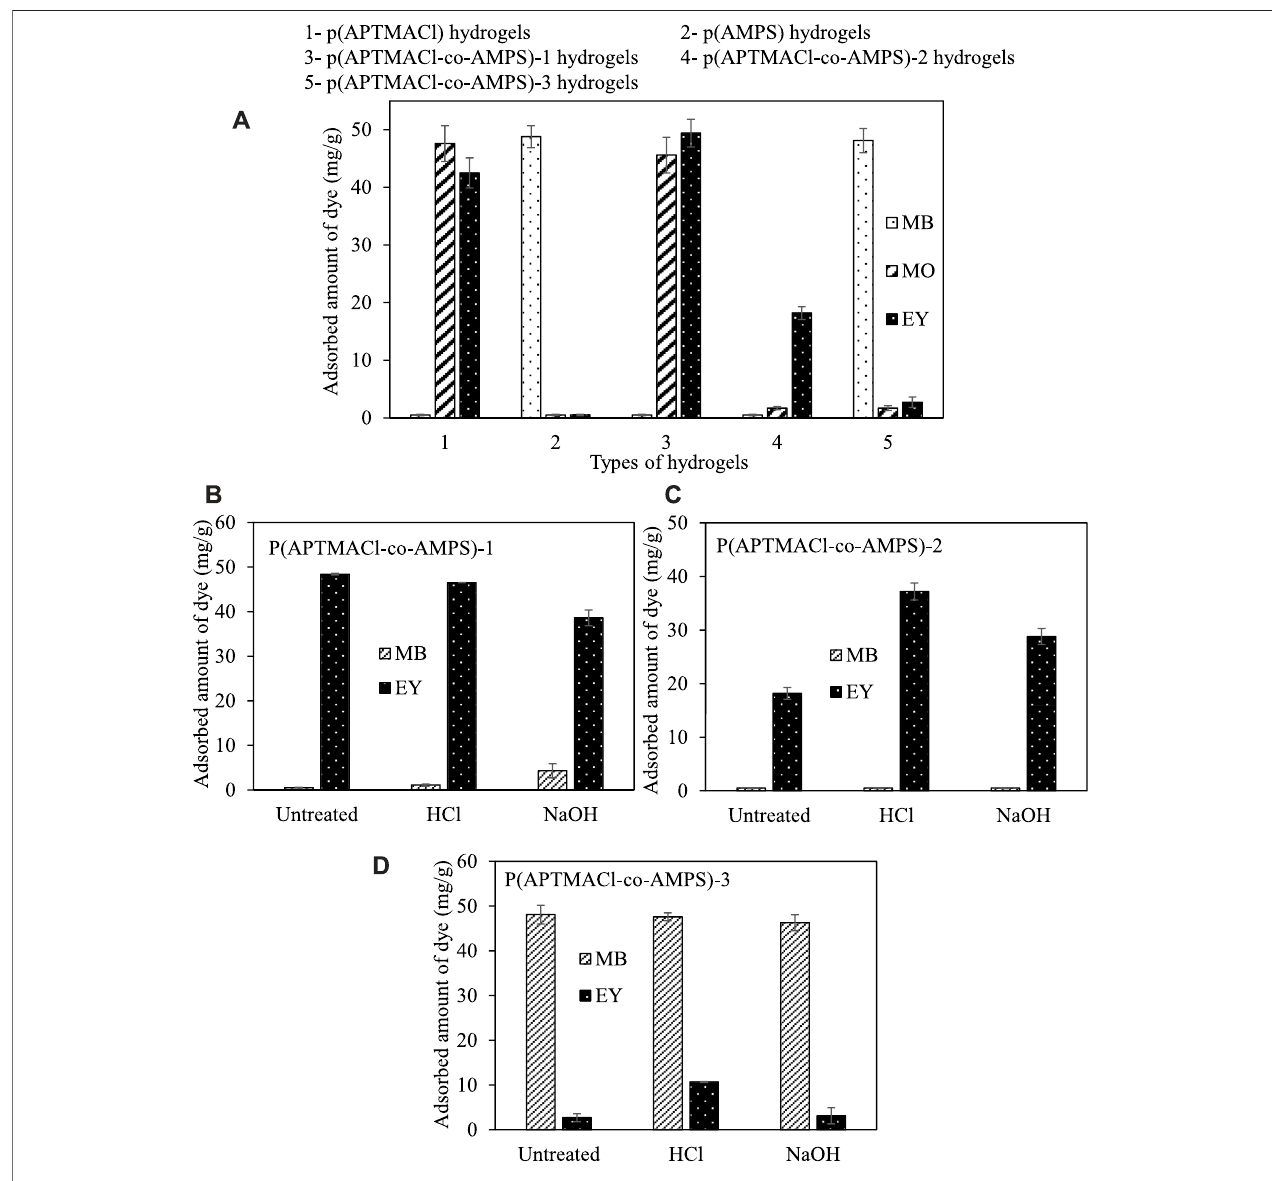
FIGURE 4 | (A) The adsorbed amounts of MB, MO, and EY dyes by cationic p (APTMACl), anionic p (AMPS) and amphoteric p (APTMACl-co-AMPS) hydrogels, and the change on dye adsorption capacities of amphoteric (B) p (APTMACl-co-AMPS)-1, (C) p (APTMACl-co-AMPS)-2, and (D) p (APTMACl-co-AMPS)-3 hydrogels after HCl and NaOH treatment. (Adsorption conditions: 50 mg hydrogel, 50 ml 50 ppm MB and EY solutions, 500 rpm stirring rate, room temperature).